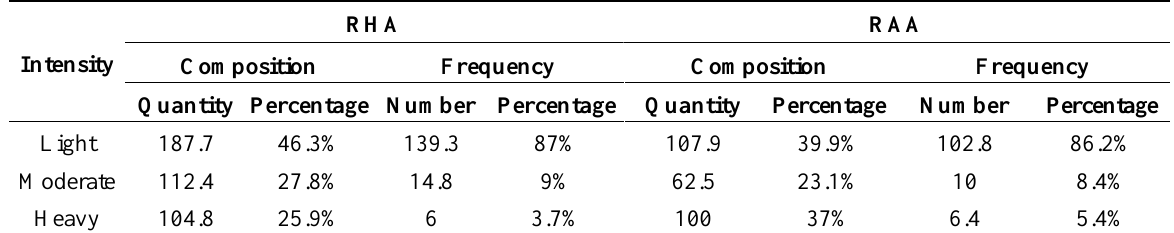
Table 2. The composition and frequency of different intensity precipitation in annual total precipitation in relative humid areas (RHA) and relative arid areas (RAA) respectively. Composition indicates that precipitation total quantity (mm) in one year and frequency indicates that the number of precipitation events in one year for each precipitation intensity. These statistics were based on daily field measurements from weather stations with 164 stations in relative humid areas and 107 stations in relative arid areas. RHA RAA Intensity